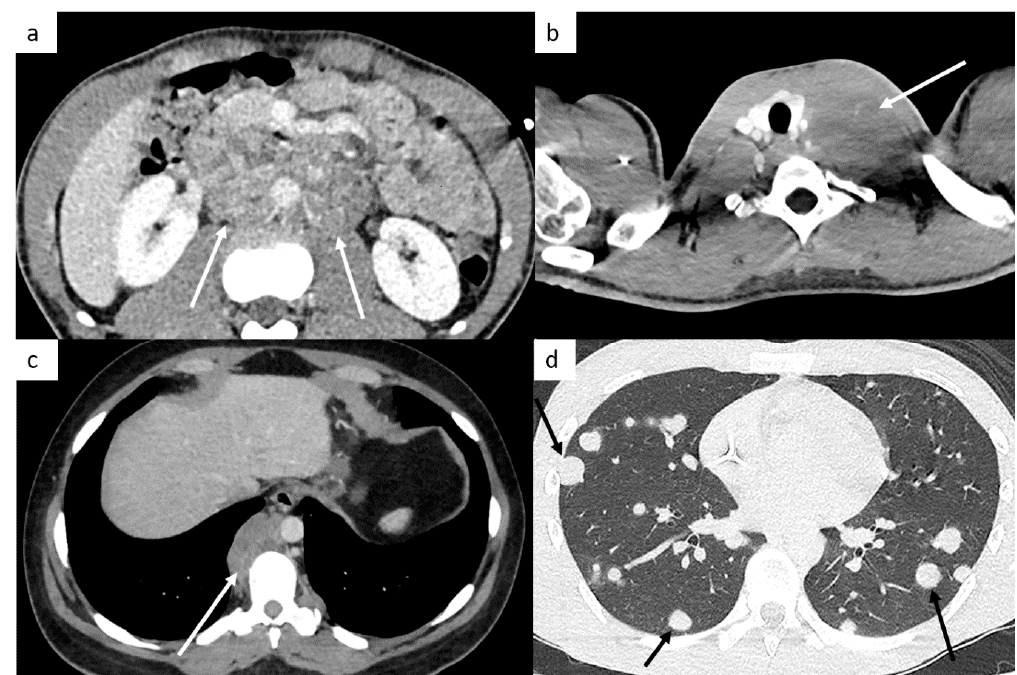
Figure 1. Most common sites of lymph nodes and metastases in testicular cancer. Abdominal computed tomography (CT) shows retroperitoneal paraaortic lymph nodes ( a , arrow). Thoracic CT reveals left supraclavicular lymph node ( b , arrow). Thoracic CT demonstrates posterior mediastinal lymph nodes ( c ). Thoracic CT scan shows lung metastases appearing as multiple lung nodules ( d ). TGCT most commonly spread to retroperitoneal lymph nodes, especially in periaortic lymph nodes because of their lymphatic and venous pathway dissemination